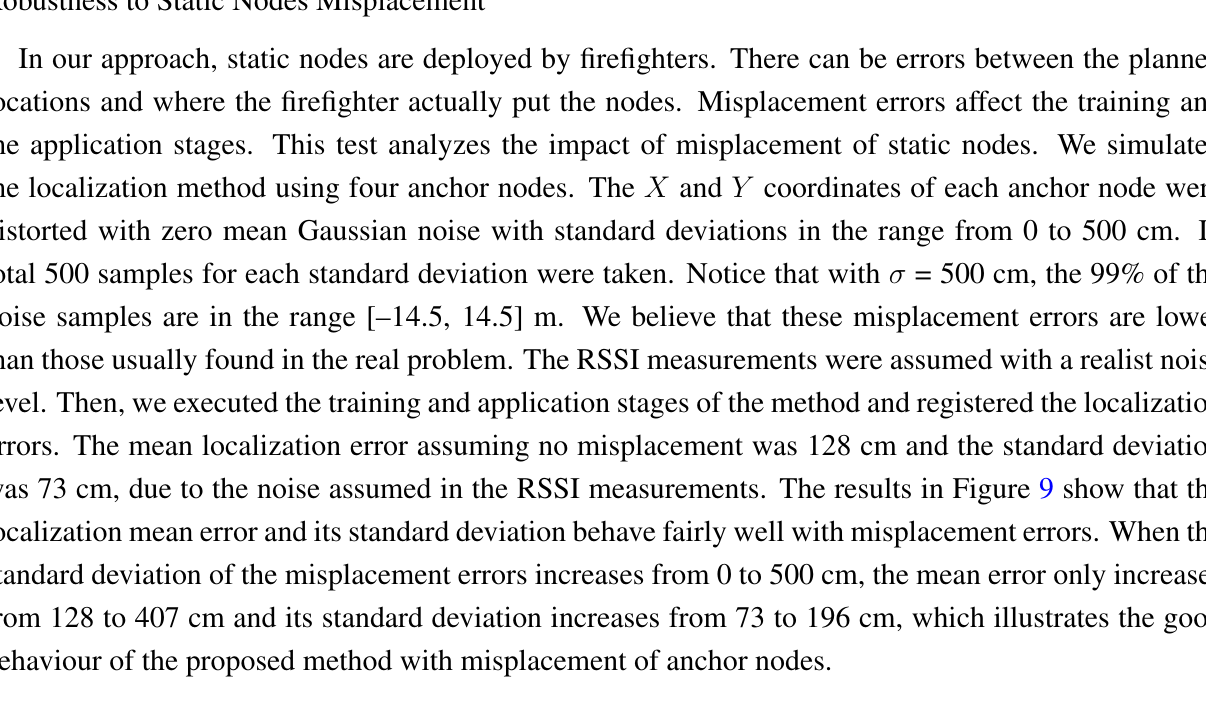
Figure 9. Impact of anchor nodes misplacement in mean localization error ( left ) and standard deviation ( right